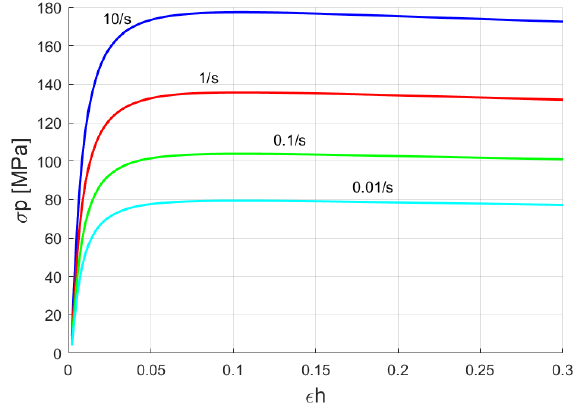
Figure 7: Curves of the predicted forging/deformation force F d as a function of the unit draft ε for different deformation strain rates ˙ φ h and constant deformation temperature T = 900 ∘